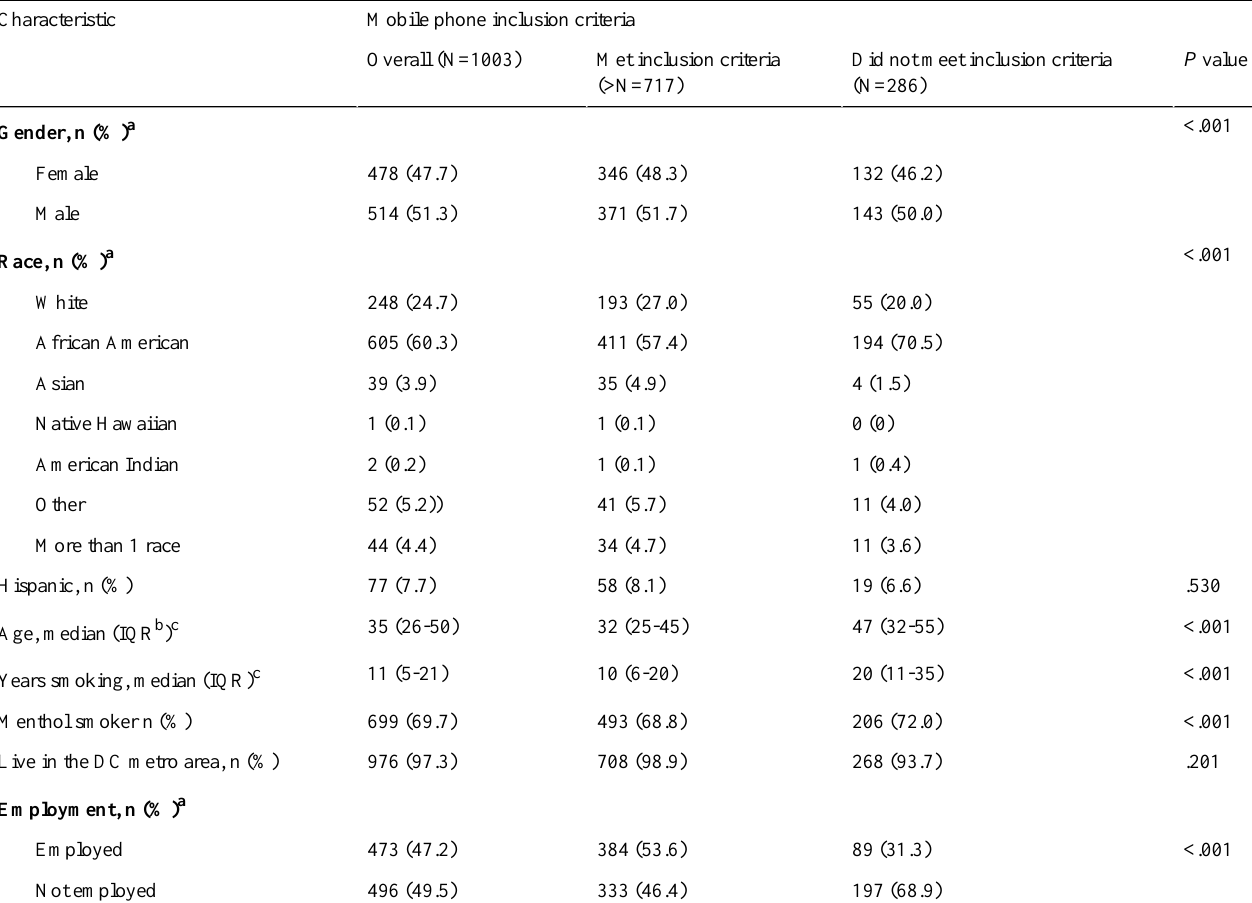
Table 1. Characteristics of individuals who took the initial online screener, overall and by mobile phone inclusion criteria, in the Washington, DC area. Mobile phone inclusion